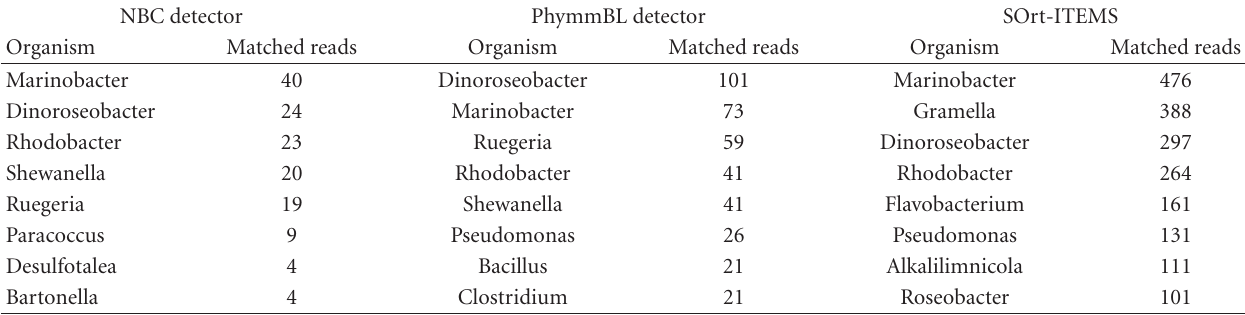
Table 5: The table shows the distribution of top 8 most abundant genus reads that passed the genus-resolution detectors for the red soudan acid mine drainage dataset, using the 635-genome training